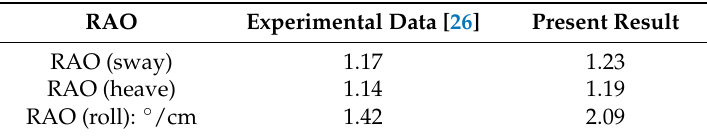
Table 1. The comparison of measured and present numerical response amplitude operators (RAO) of the motion responses. RAO Experimental Data [26] Present Result RAO (sway) 1.17 1.23 RAO (heave) RAO (roll): °/cm